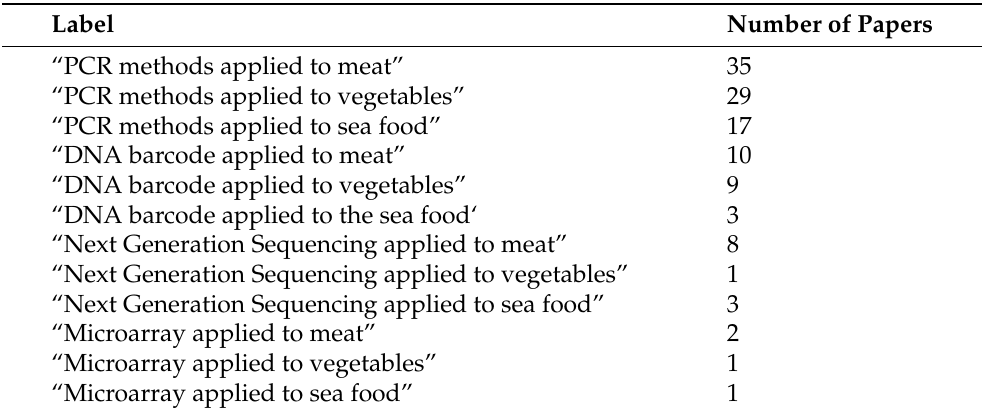
Table 4. Papers classified per Human-Readable